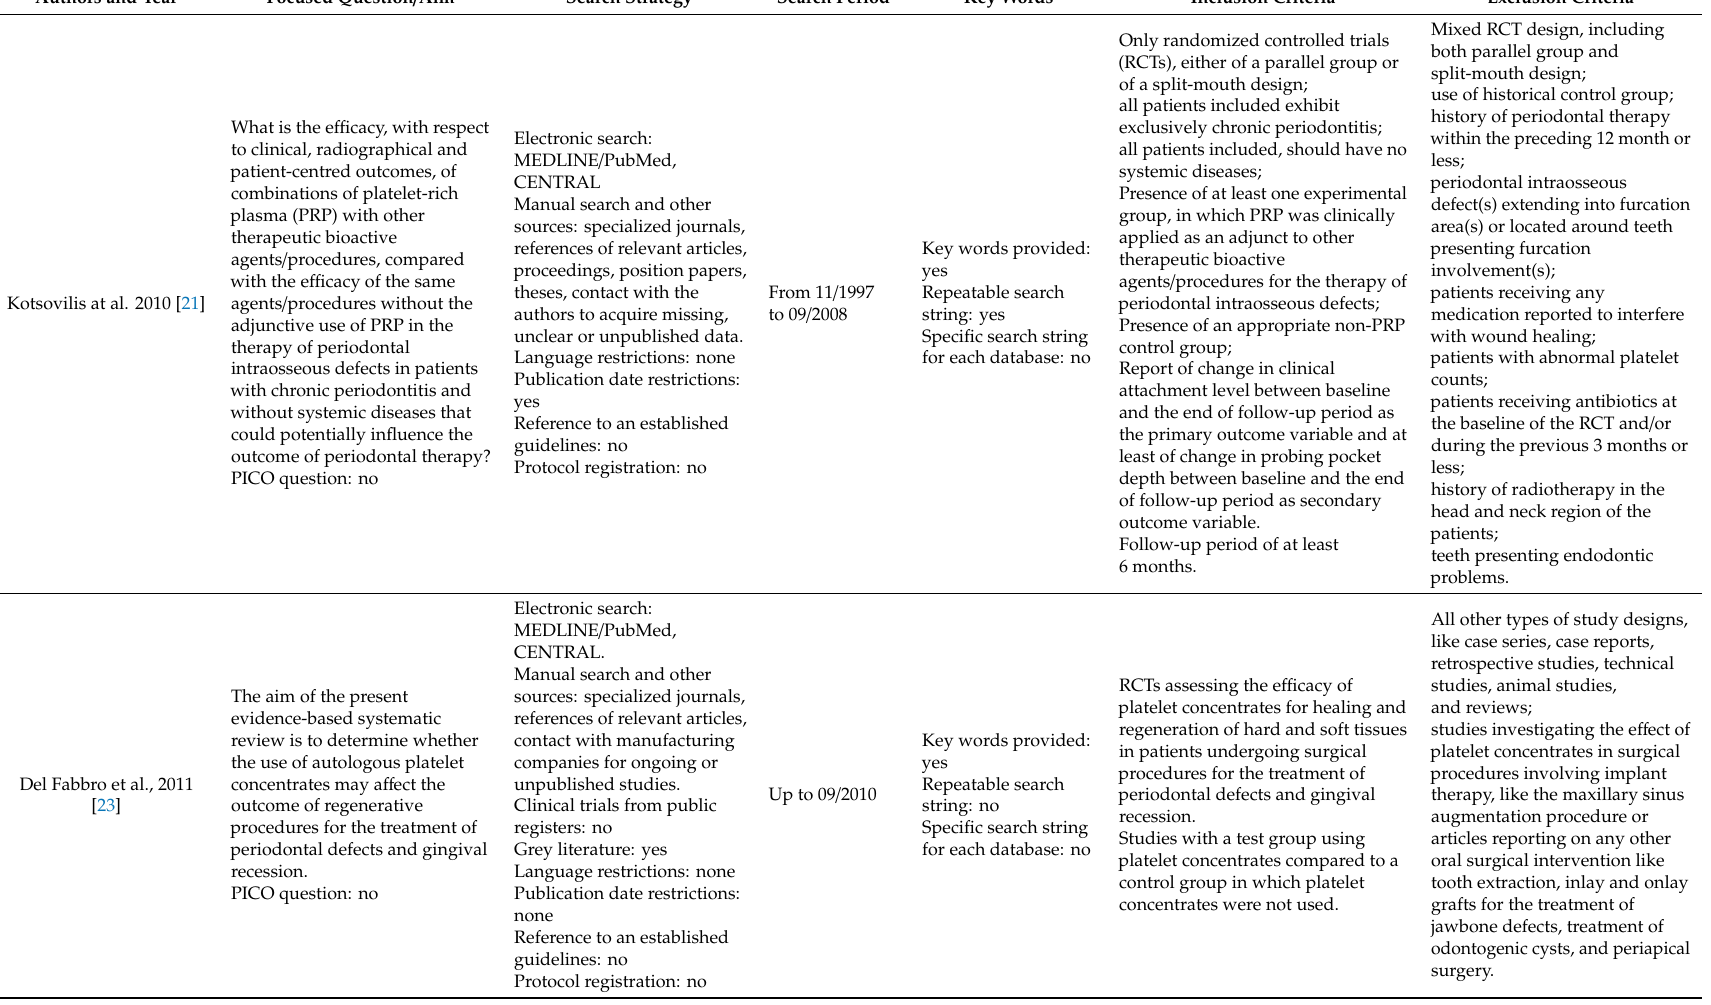
Table 3. Characteristics of the included studies: search